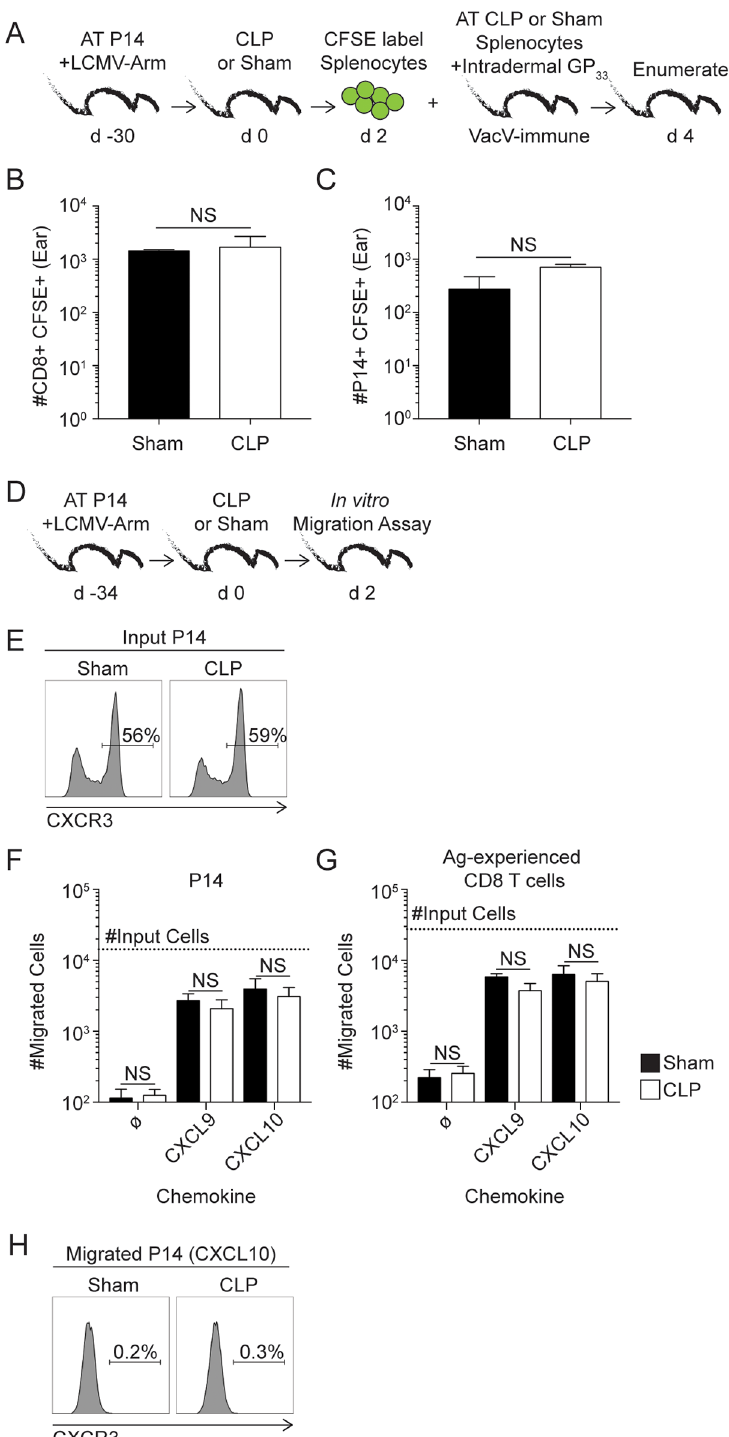
Fig 4. Capacity of circulatory memory CD8 T cells to follow inflammatory cues and migrate to the inflamed tissue is not influenced by sepsis. (A) Experimental design.Two days after CLP or sham surgery splenocytes from LCMV-Arm immune P14 chimeramice were harvested, CFSE labeled,and transferred into VacV-GP 33 immune recipients that containedP14 T RM before in vivo peptidestimulationof the skin. (B) Number of CD8+ CD45.2- CFSE+ and (C) P14 CD45.2- CFSE+ cells in the ear 48 hours after skin T RM